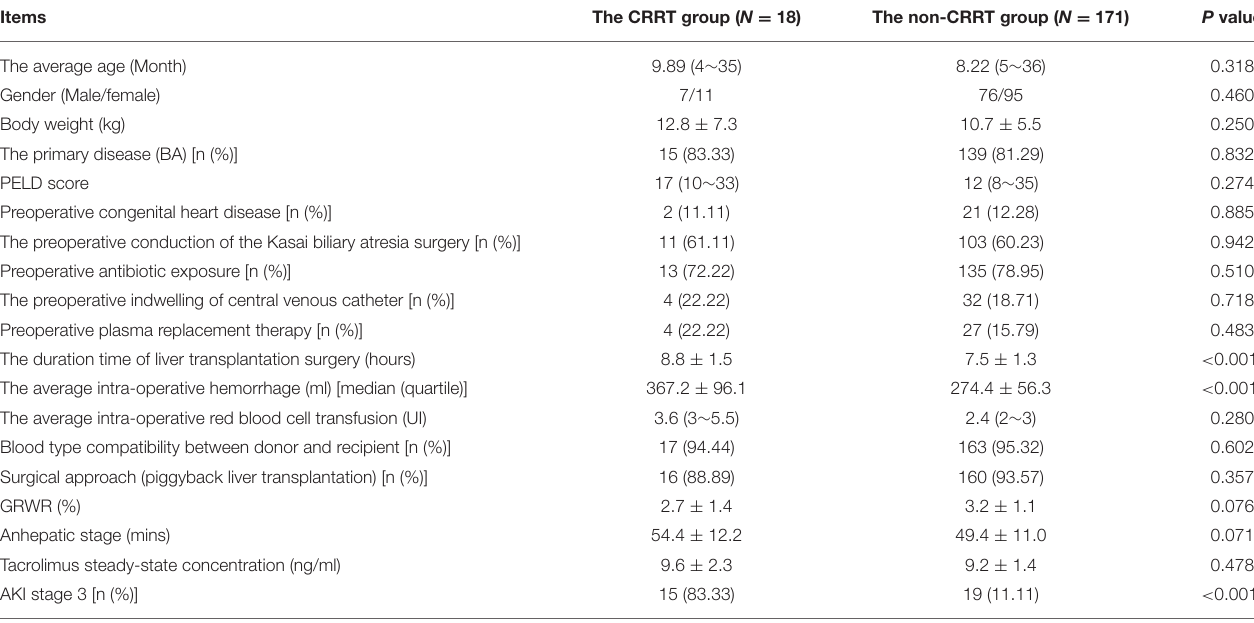
TABLE 1 | Comparison of perioperative baseline characteristics between the CRRT group and non-CRRT group of pediatric patients with acute kidney injury. Items